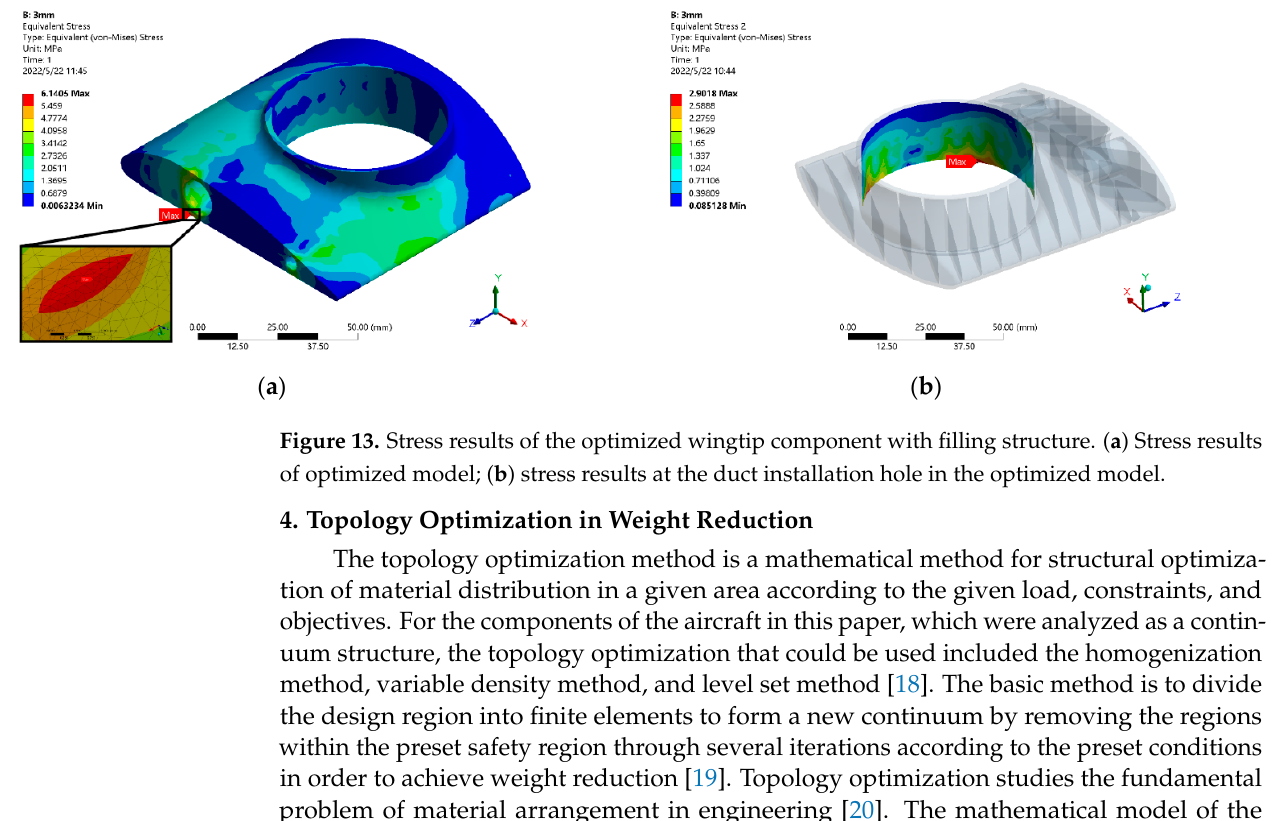
10 of 20 Figure 11. Tensile strength of sample components with different fillings. 3.3. Optimization Results Based on analysis and calculations, there was a stress concentration on the wingtip mounting hole that connects to the wing. The installation region of the ducted fan was complicated. Apart from the reaction of the thrust and additional torque of the ducted fan in the simulation, there were also forces from vibration and aerodynamic interference. Thus, special attention should be paid to the region with complex forces. After compre- hensively considering installation and manufacture, the honeycomb filling structure was used with the end of two holes connecting the component with the wing as the interface, along the direction of maximum stress and the direction of 45°, as shown in Figure 12. As a result of the optimization, the weight of the component was changed from 90.53 g in solid state to 34.42 g. Under this optimization scheme and compared with the solid con- dition, the weight loss was 61.98%. Compared with the hollow condition with interface, the extra weight of the honeycomb filled structure was 7.46 g. Figure 12. Reinforced filling structure. Three kinds of meshes were established—4 mm, 3 mm and 2 mm—and the maximum variation of the equivalent stress was less than 1.5% under these conditions. Among them, at the 3 mm mesh size, there were 34,959 mesh elements and the number of mesh nodes was 62,934. The stress characteristics of the model at this time are shown in Figure 13. The